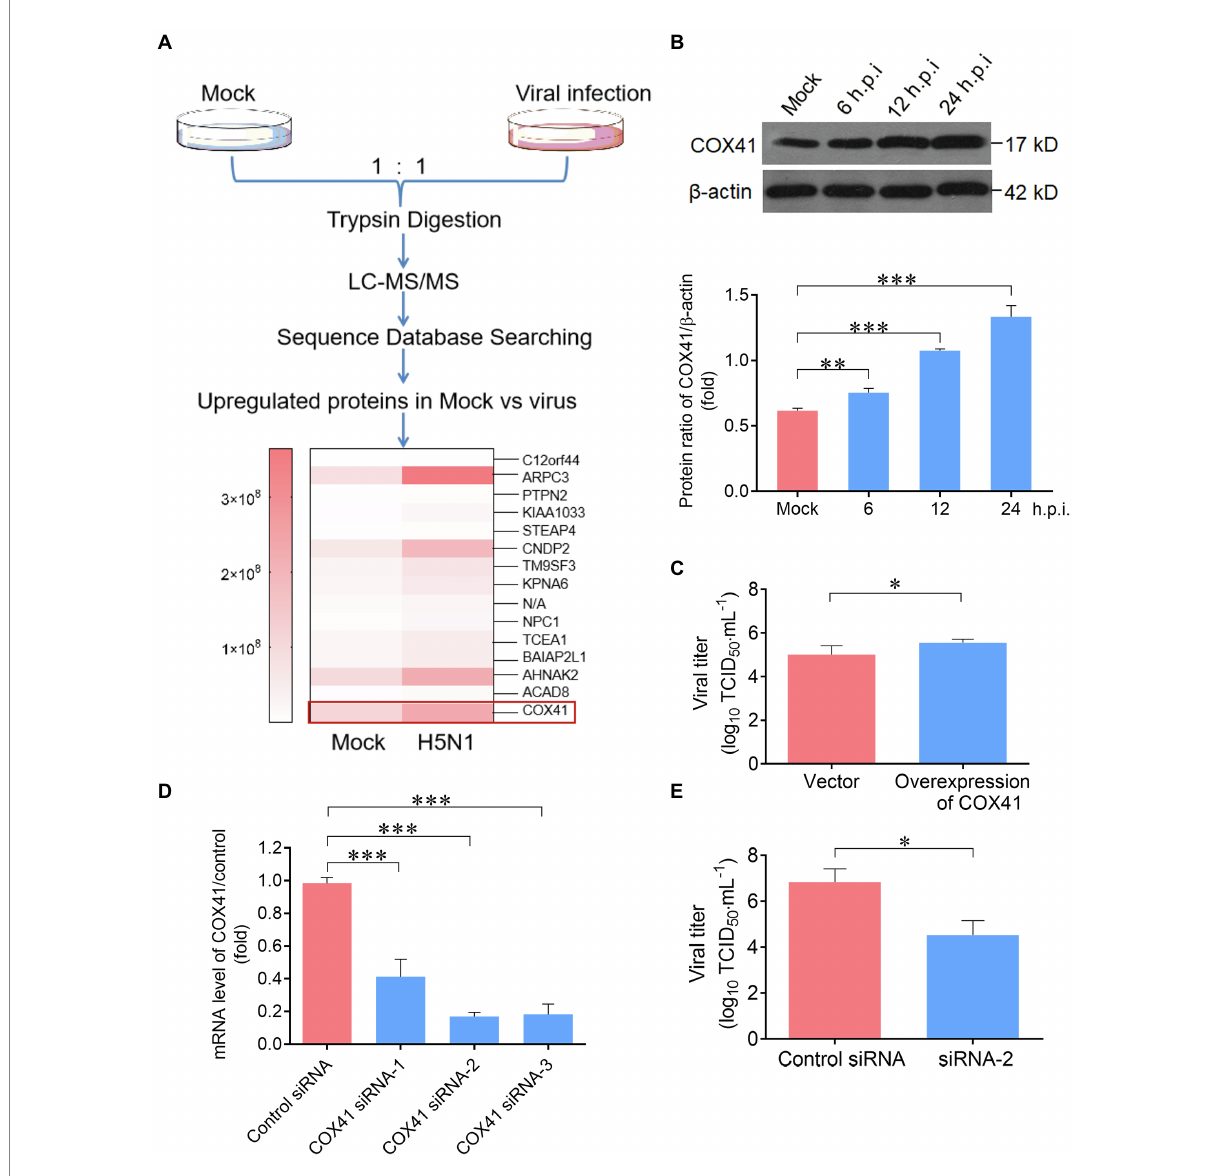
FIGURE 1 Cytochrome c oxidase subunit 4 isoform 1 (COX41) was involved in the replication of H5N1. (A) Scheme illustrating the proteomic analysis of Madin Darby Canine Kidney (MDCK) cells in responses to H5N1 infection. MDCK cells were infected with H5N1 (MOI, 1) and detected at 12 h. The differentially expressed proteins were presented as a heat map. (B) Expression of COX41 was upregulated by H5N1 infection. MDCK cells were infected with H5N1 for 6 h (MOI, 5), 12 h (MOI, 5), and 24 h (MOI, 0.01), respectively. The level of COX41 was assessed by Western blot and quantitatively analyzed using ImageJ software. Data are mean ± s.d. ( n = 2 ~ 3). ** p < 0.01; *** p < 0.001. (C) Overexpression of COX41 in cells increased the viral titers. HEK293T cells were transfected with plasmids expressing FLAG-tagged COX41 and then infected with H5N1 (MOI, 0.01). Viral titers were assessed at 72 h postinfection by TCID 50 assay. Data are mean ± s.d. ( n = 3). * p < 0.05. (D) Detection of COX41 mRNA level in HEK293T cells transfected with COX41 siRNAs targeting COX41 genes at 24 h.p.i. Data are mean ± s.d. ( n = 3). (E) Effects of COX41 siRNAs on viral titers